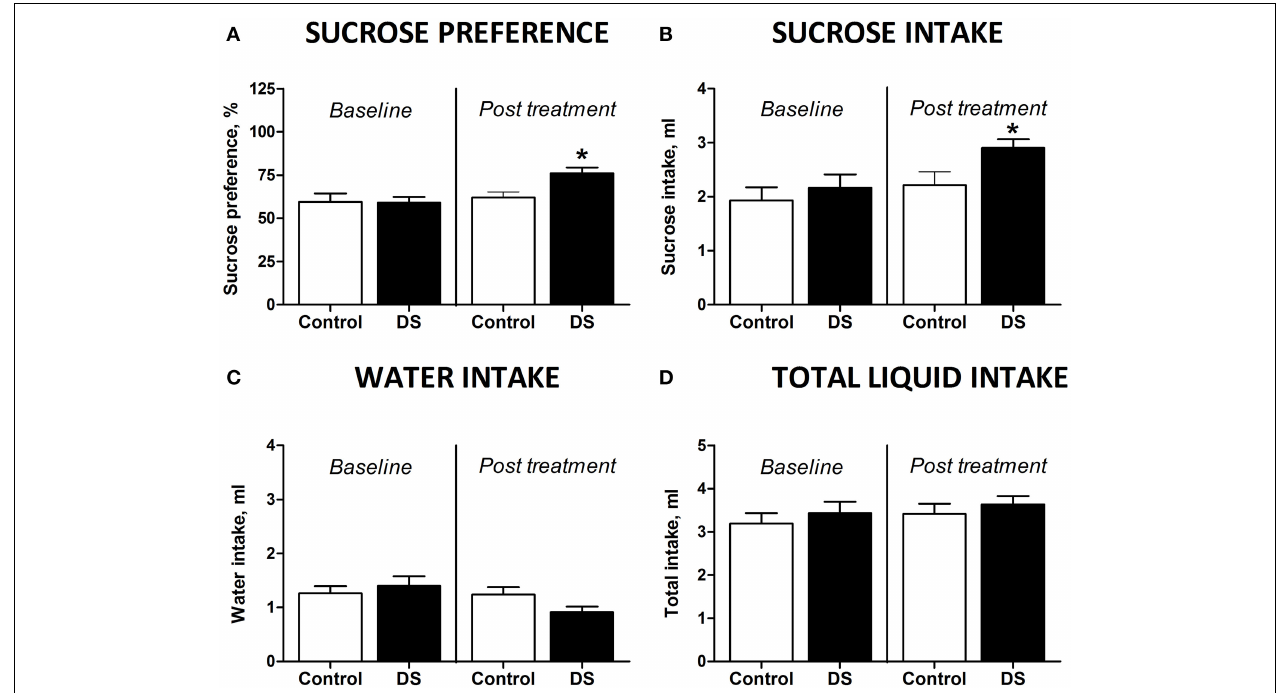
FIGURE 3 | Effects of Dicholine Succinate in a model of elderly depression. (A) In 18 month aged animals, only the DS treated group showed an increase in sucrose preference ( ∗ p < 0 . 05 vs. controls) while non-treated animals had no increased sucrose preference ( p > 0 . 05). (B) Total sucrose intake was not changed in animals without treatment ( p > 0 . 05)